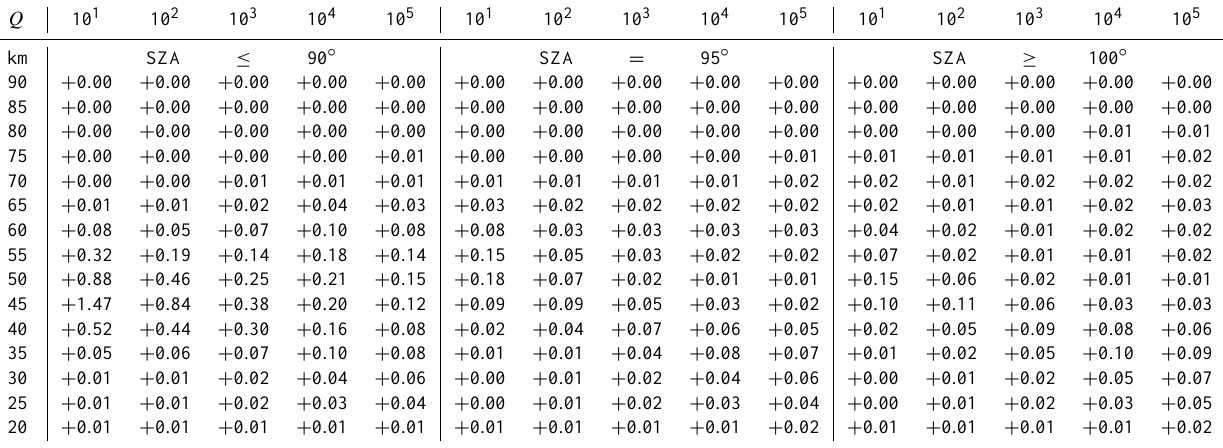
/Q for October SH. 3